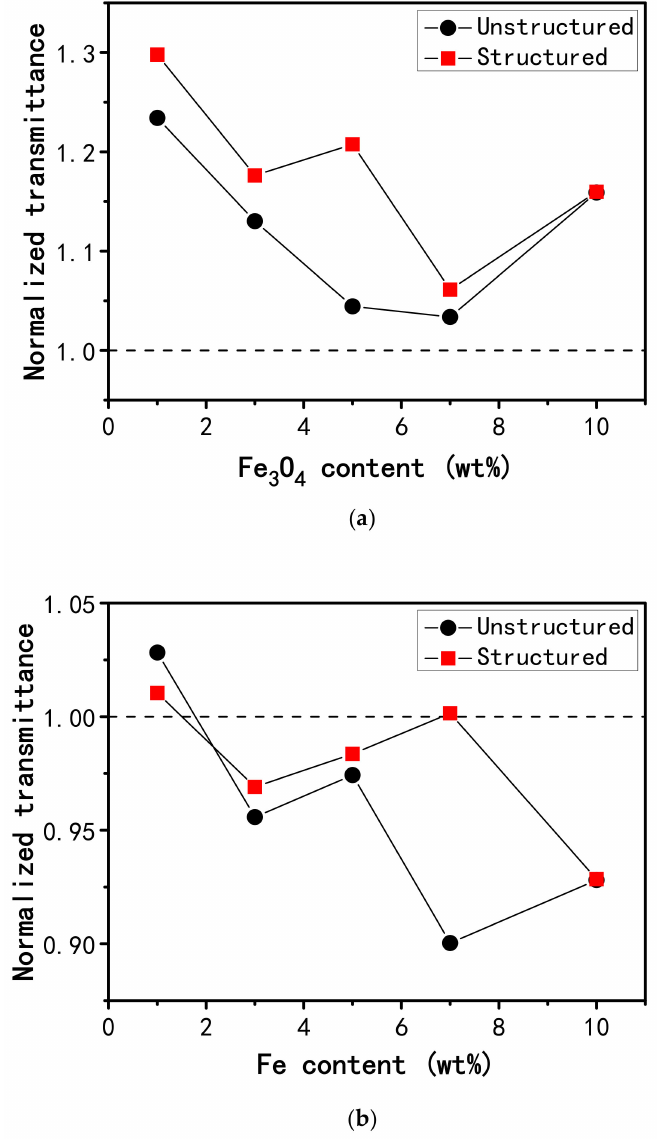
Figure 2. Film transmittance under magnetic field plotted as a function of nanoparticle loading for the unstructured (circles) and structured (squares) samples: ( a ) Fe 3 O 4 -PDMS films, and ( b ) Fe-PDMS